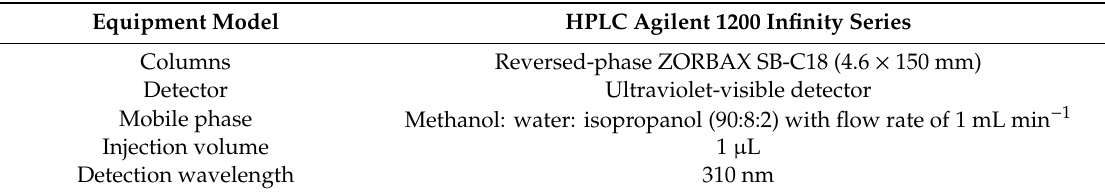
Table 2. HPLC instrumentation and